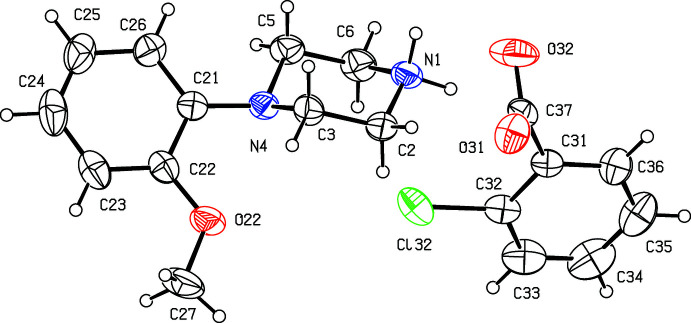
The independent components of compound (V) showing the atom-labelling scheme. Displacement ellipsoids are drawn at the 30% probability level.